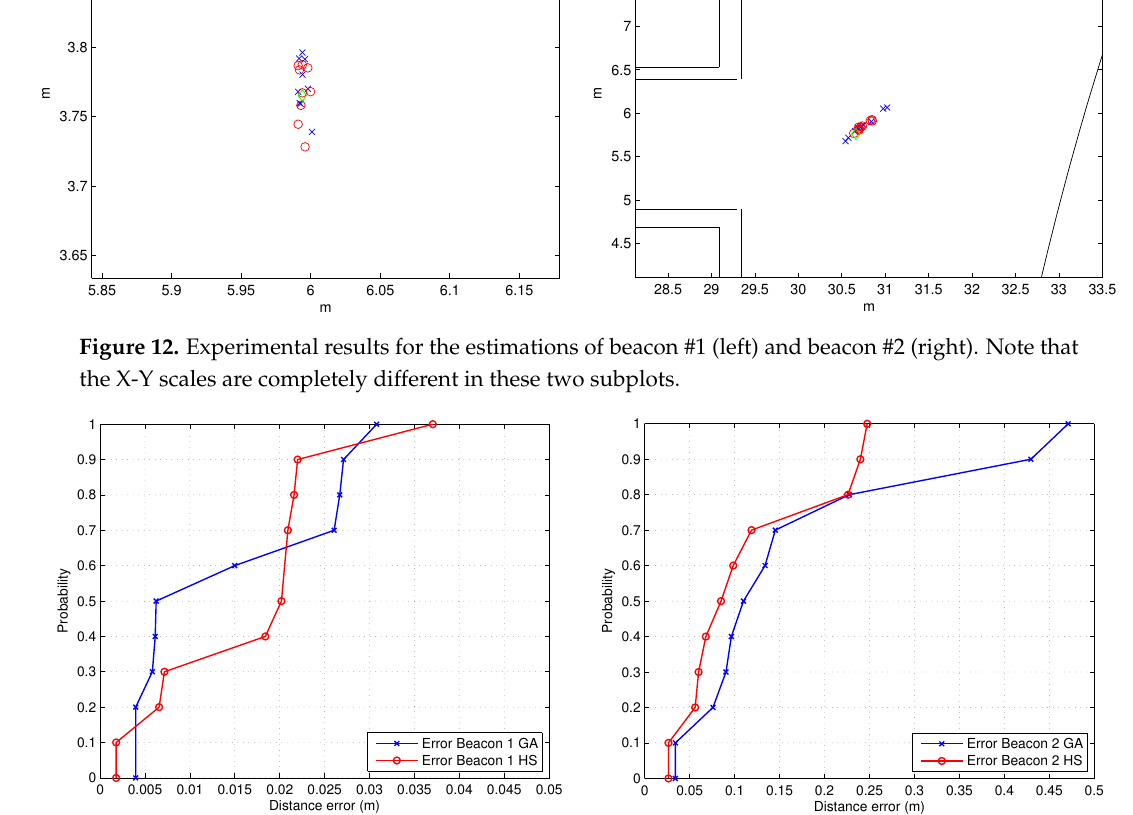
Figure 13. CDFs of the error related to the estimation of the positions for beacon #1 (left) and beacon #2 (right).